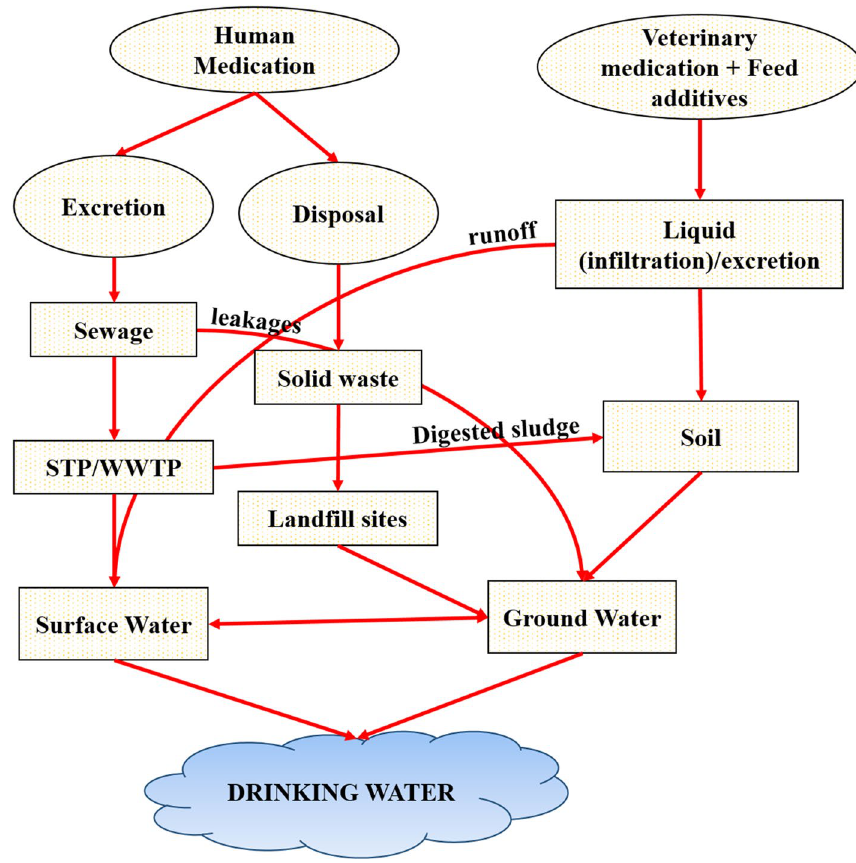
Fig. 1 Possible pathways of pharmaceuticals entering the water source (specific to study